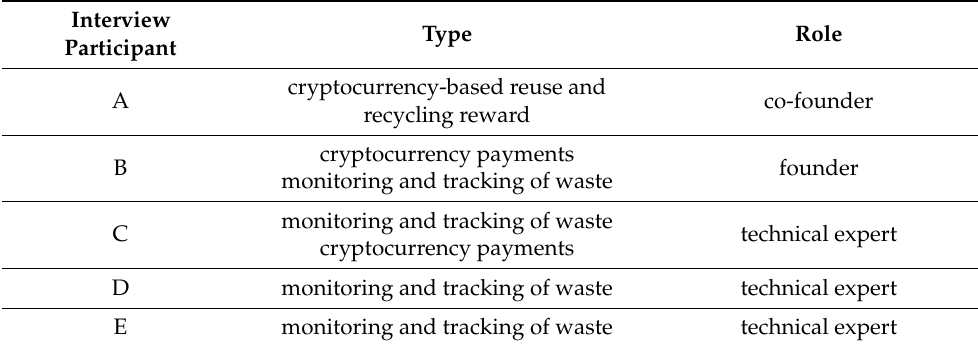
Table A4. Interview participant